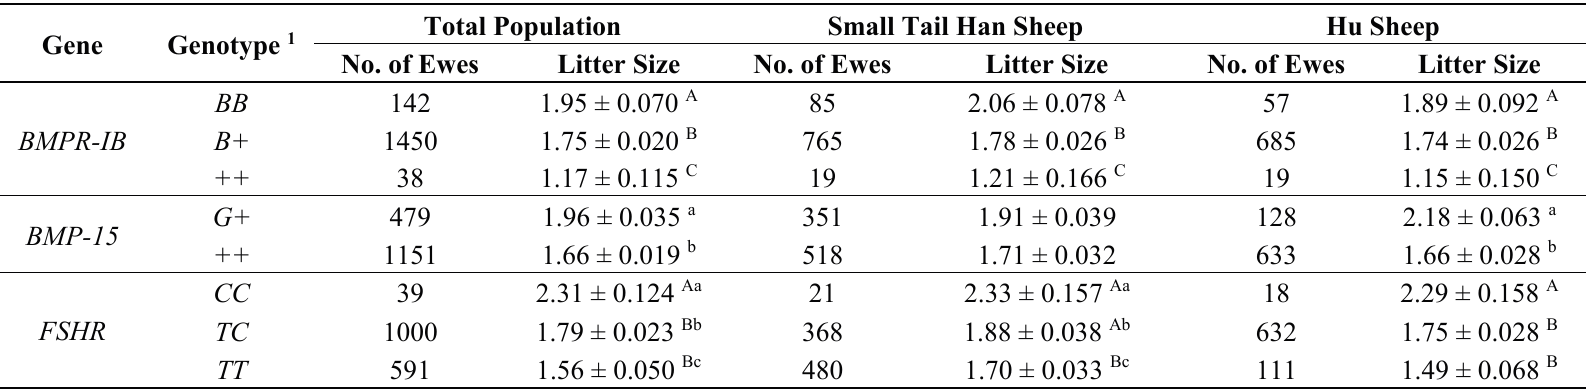
Table 2. Association results between the genotypes of the ovine BMPR-IB , BMP-15 and FSHR genes and litter